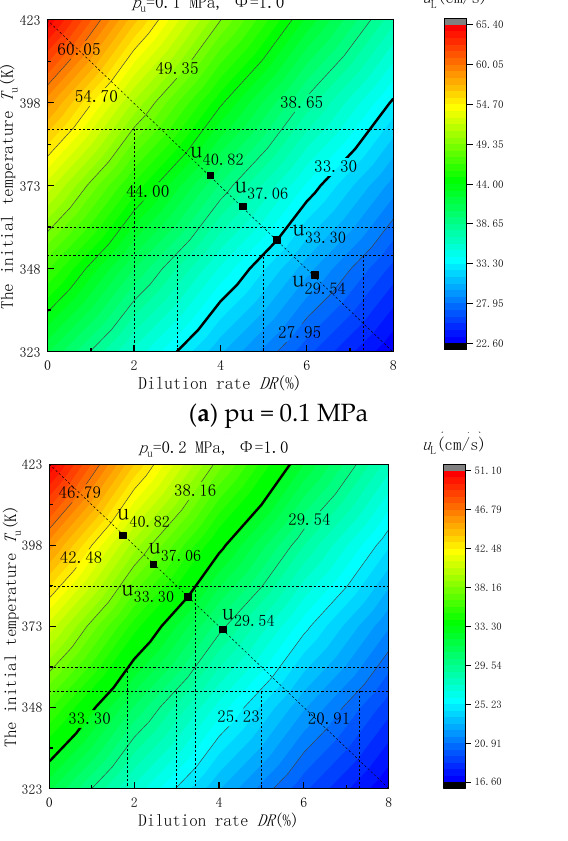
Energies 2021 , 14 , x FOR PEER REVIEW